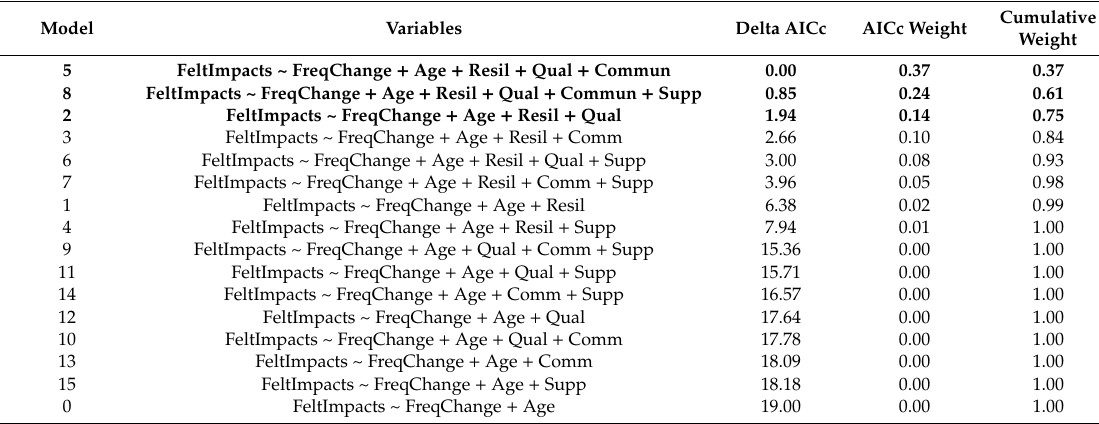
Table 5. Linear models determining the e ff ects of protective factors on felt impacts of perceived environmental changes. Retained models are shown in bold.